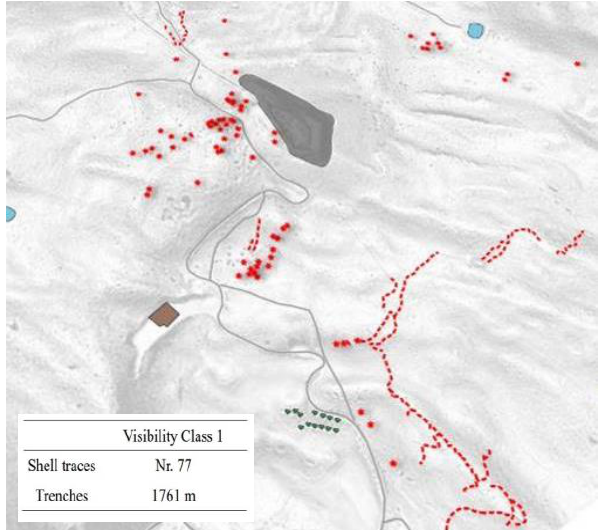
Figure 16 . Remains localization on the current Digital Terrain Model (LIDAR data 2015)